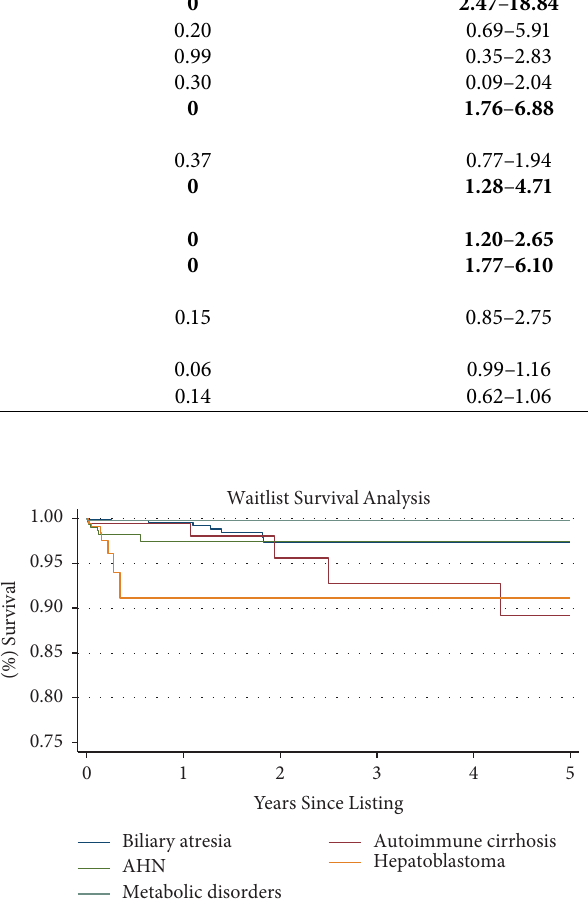
Figure 2: Waitlist survival analysis. Kaplan–Meier survival function over 5 years for patient survival in pediatric patients listed for liver transplant from listing until death or removal from the waitlist, without undergoing transplantation, by